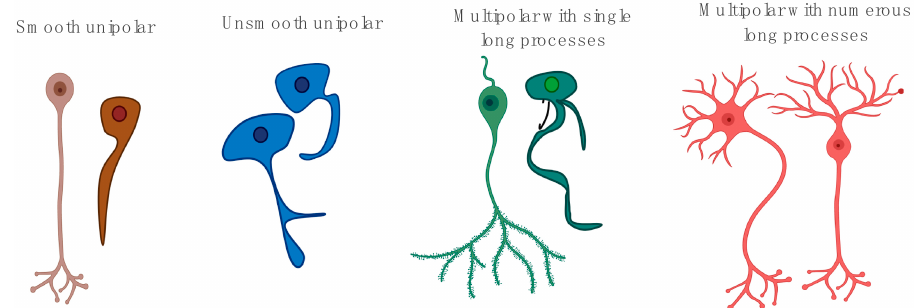
Figure 2. Different morphology of neurons found in ganglionated plexi (GP) sites in humans. There are three types of neurons that are populated in GP sites. These are either unipolar (brown, blue) or multipolar (green, red) having either single (brown, blue, green) or multiple (red) processes.